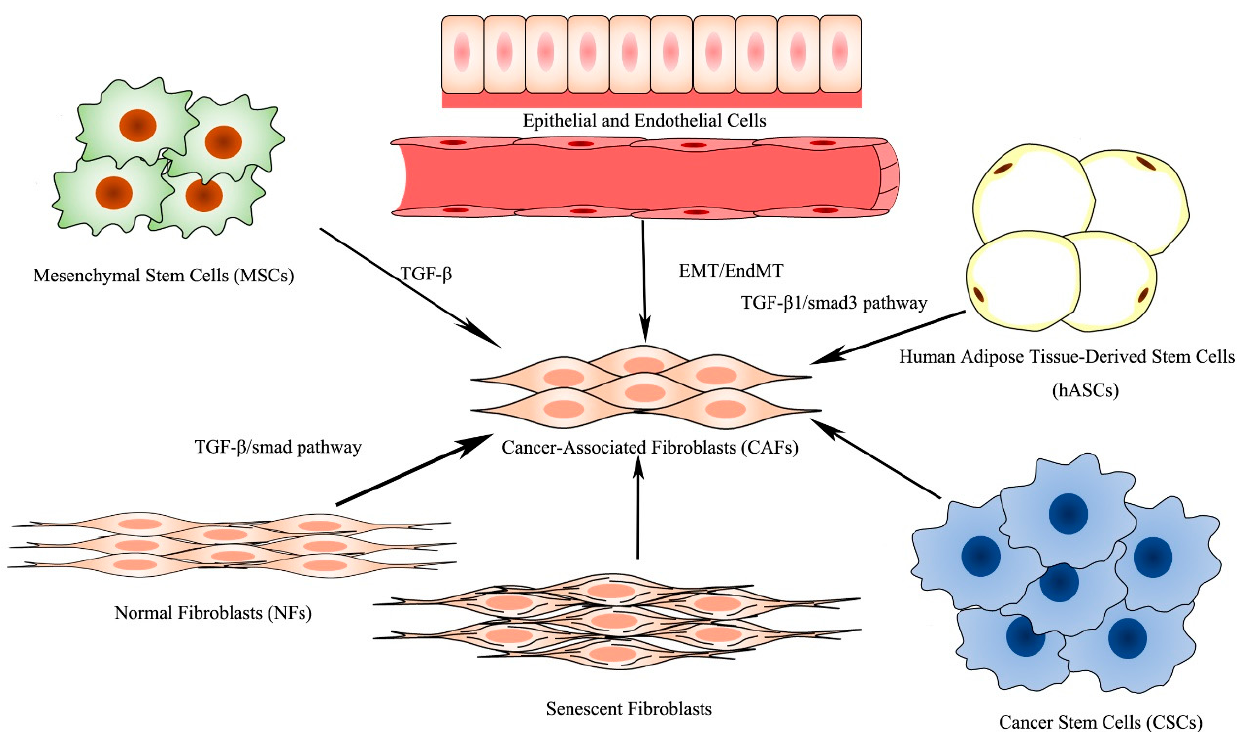
Figure 2. Origin of CAFs.